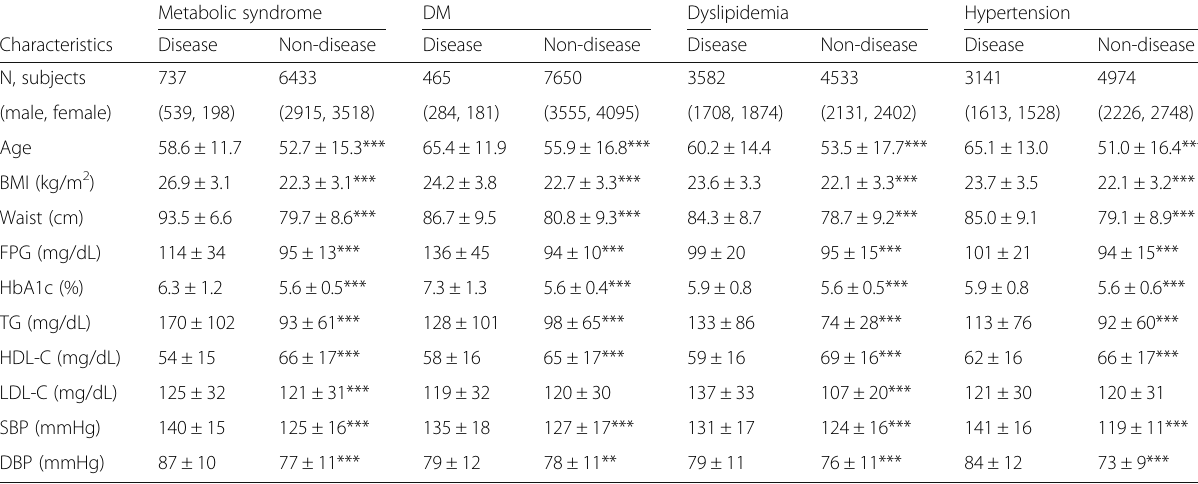
Table 1 Demographic and clinical characteristics of the study subjects. Values are expressed as means ± standard deviations for continuous